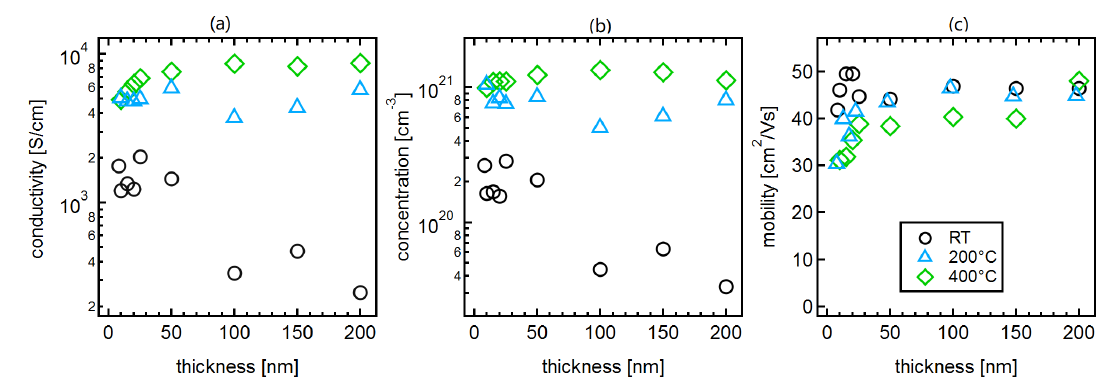
Figure 2. Electrical properties of ITO thin films deposited at different temperatures. Conductivity ( a ), carrier concentration ( b ) and carrier mobility ( c ) of ITO films deposited at room temperature, 200 ◦ C and 400 ◦ C, as a function of film